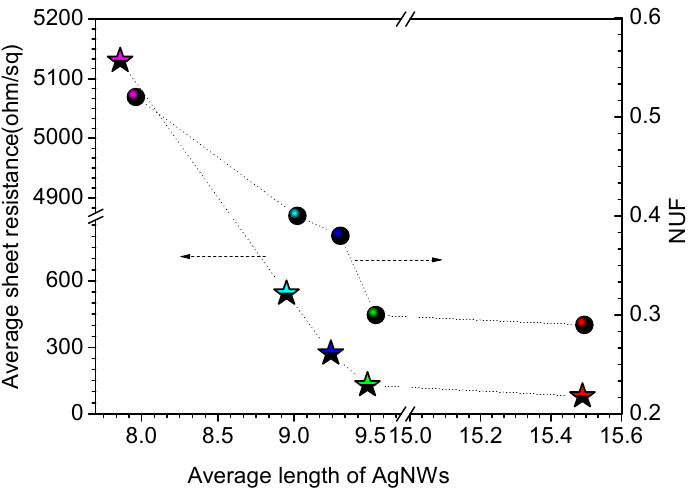
Figure 5. Sheet resistance and non-uniformity factor ( NUF) of the sheet resistance of films consisting of AgNWs of different lengths.